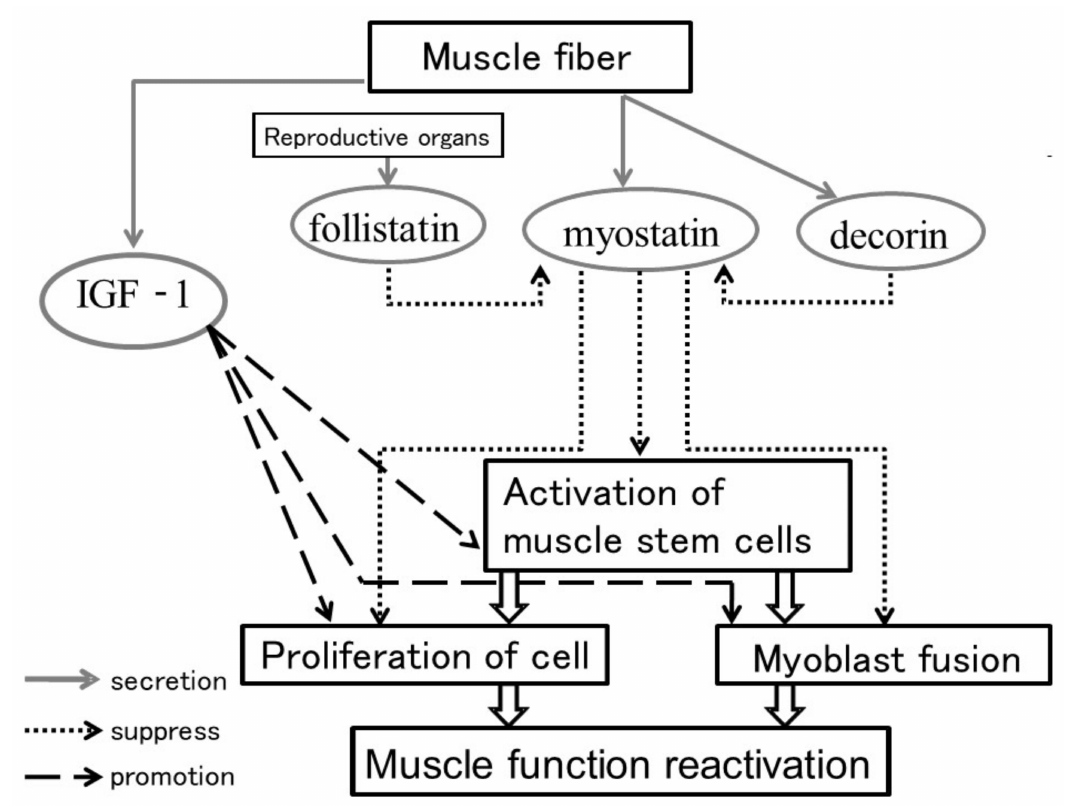
Figure 2. Factors associated with muscle development and hypertrophy. Growth factors such as IGF-1 promote the proliferation and fusion of myoblasts and promote the activity and self-renewal of satellite cells, which are muscle stem cells, thereby promoting muscle development and muscle hypertrophy [23]. On the other hand, it has been reported that myostatin secreted from muscle cells suppresses the proliferation and fusion of myoblasts and suppresses the activity and self-renewal of satellite cells, thereby suppressing muscle development and muscle hypertrophy [25–27]. Furthermore, the function of follistatin/decorin [28,29], which regulates the function of myostatin, has also been reported. Follistatin inhibits the action of myostatin by binding to myostatin [28]. Decorin is a protein produced by muscle cells at the same time as myostatin, and it has been reported that it regulates the activity of myostatin by binding to myostatin